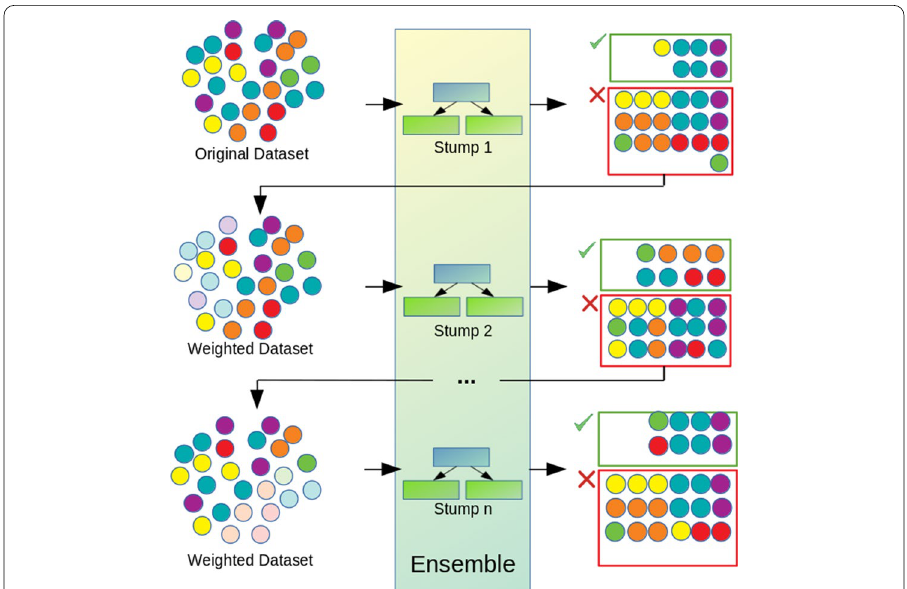
Fig. 6 Ensemble sequentially in boosting (source